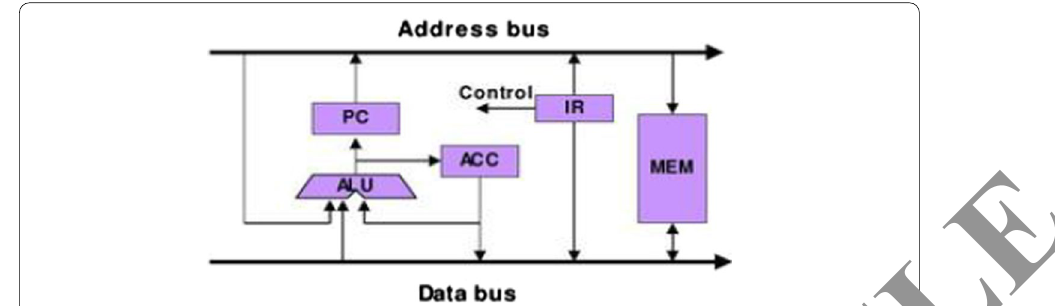
Fig. 3 The internal structure of the wall painting pattern system (http:// alturl. com/